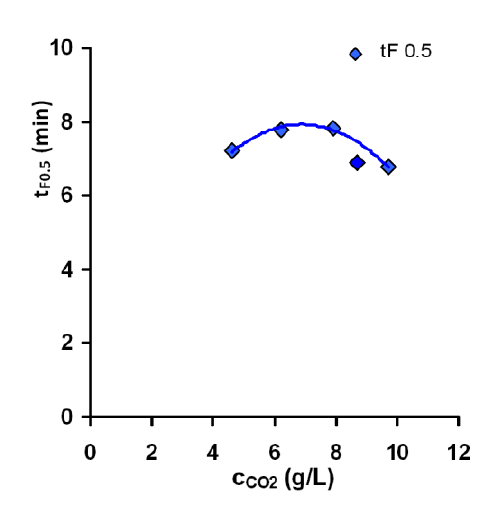
Fig. 8. Foam decay – effect of CO 2 content: parameter t F0.5 .